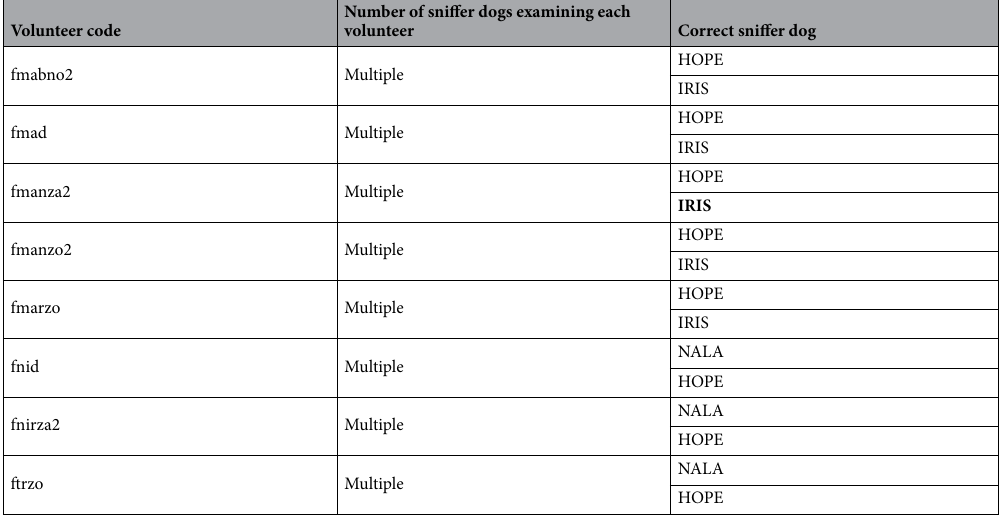
Table 5. Summary of results from volunteers who tested negative on the rapid antigen test (RAD) and were sniffed by the sniffer dogs in the field work, grouped based on being sniffed by a single dog (one) or multiple dogs (multiple). Name of sniffer dogs with wrong choices are in